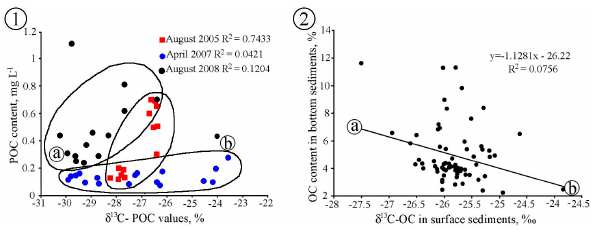
Fig. 11. δ 13 C values of POC (1) and surface sediments (2) vs. POC concentrations (1) (mgl − 1 ) and OC content in surface sediment (2) (%). The linear correlations suggest mixing between two end- members hypothesized to be allochthonous (a) and autochthonous (b)